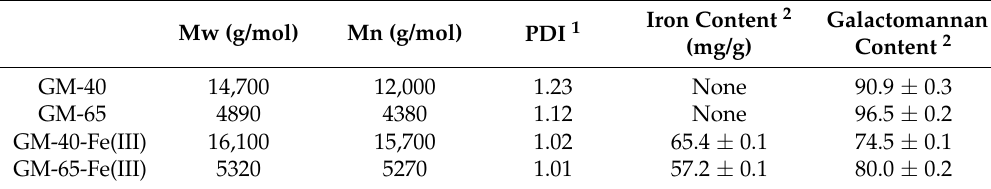
Table 1. Galactomannan content, molecular weight and iron content in galactomannan and galactomannan – iron(III) complexes.